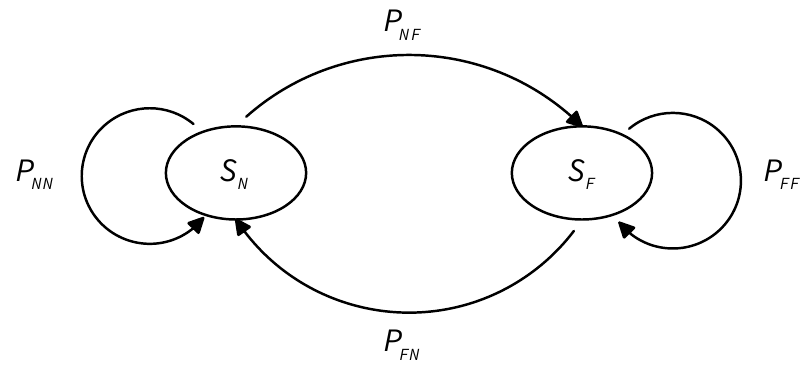
Figure 2. Two-state Markov model.